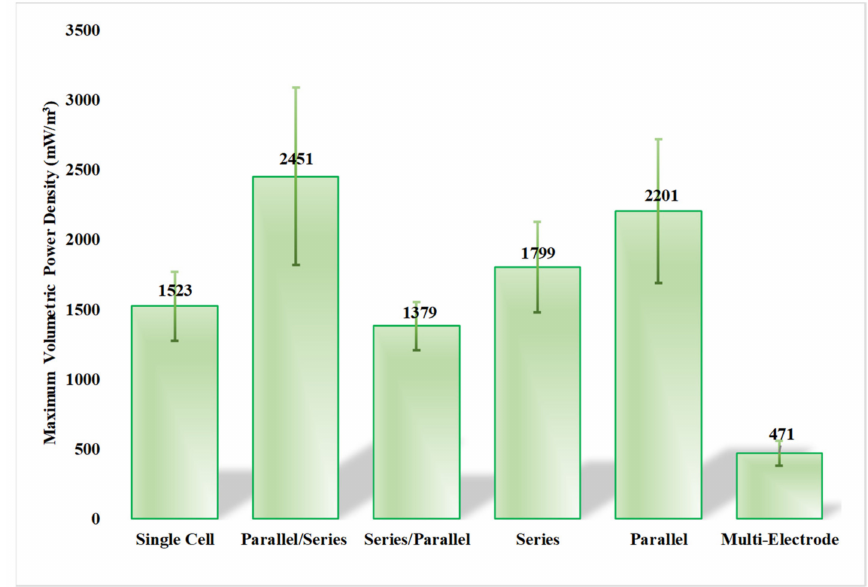
Figure 12. Comparison among the maximum volumetric power